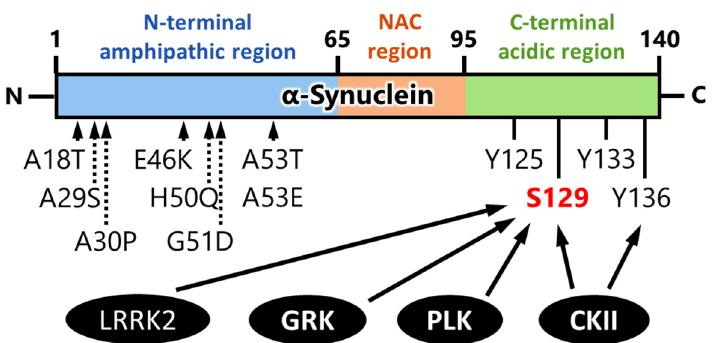
Figure 3. Summary of representative phosphorylation sites, kinases, and mutation sites of α - synuclein [54–64]. GRK: G-protein-coupled receptor kinase; CKII: casein kinase II; PLK: polo-like kinase; LRRK2: leucine-rich repeat kinase 2; NAC: non-amyloid